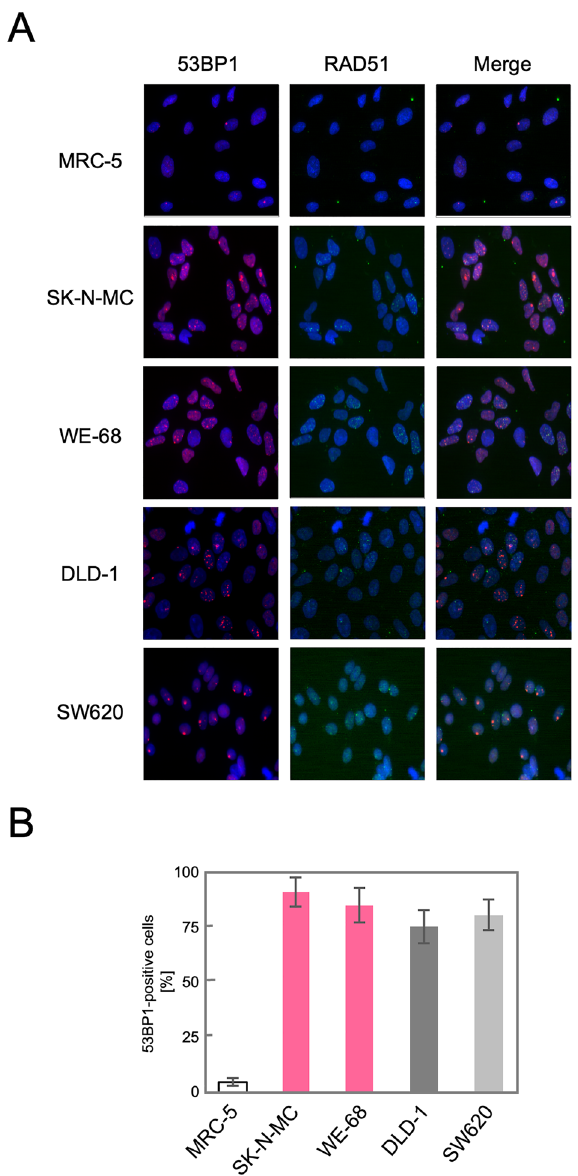
Figure 3. 53BP1 co-localizes to RAD51 foci in Ewing sarcoma cells. 53BP1 foci were similarly assayed (see Fig. 2) ( A ). 53BP1 foci-positive cells were counted and compared ( B